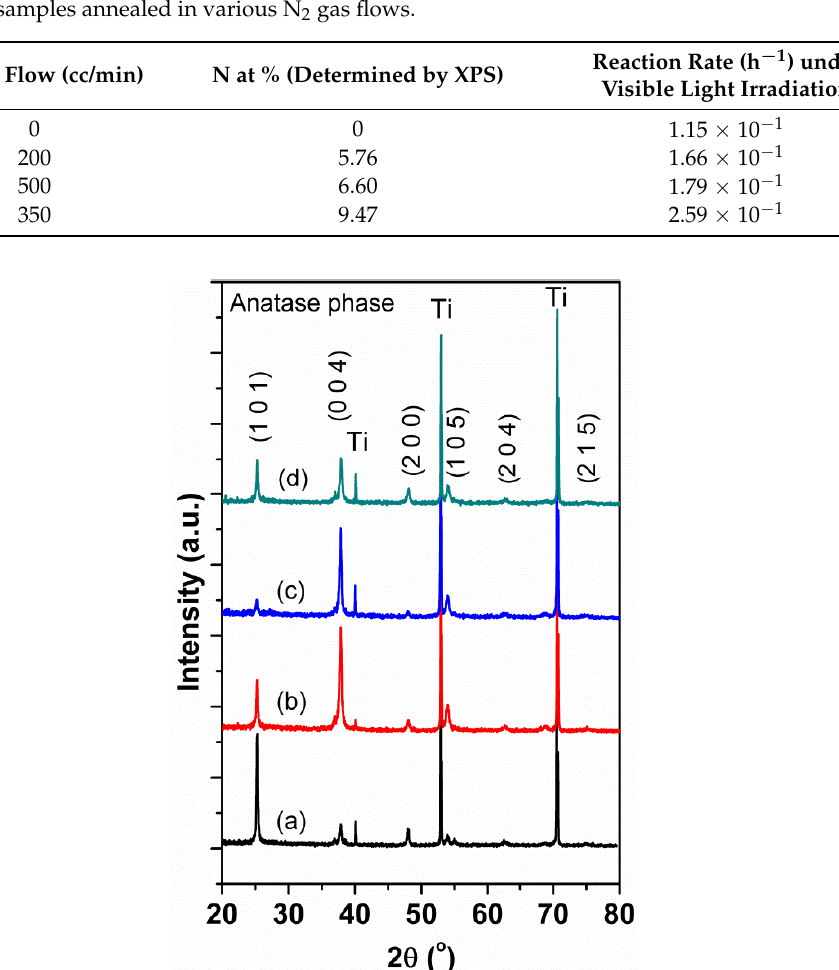
Figure 1. The XRD patterns of the pristine TNAs and N-doped TNAs with various N concentrations prepared by thermal annealing under different N 2 gas flows: ( a ) 0 at % N in vacuum, ( b ) 5.76 at % N at 200 cc/min, ( c ) 9.47 at % N at 350 cc/min, and 6.60 at % N at 500 cc/min.